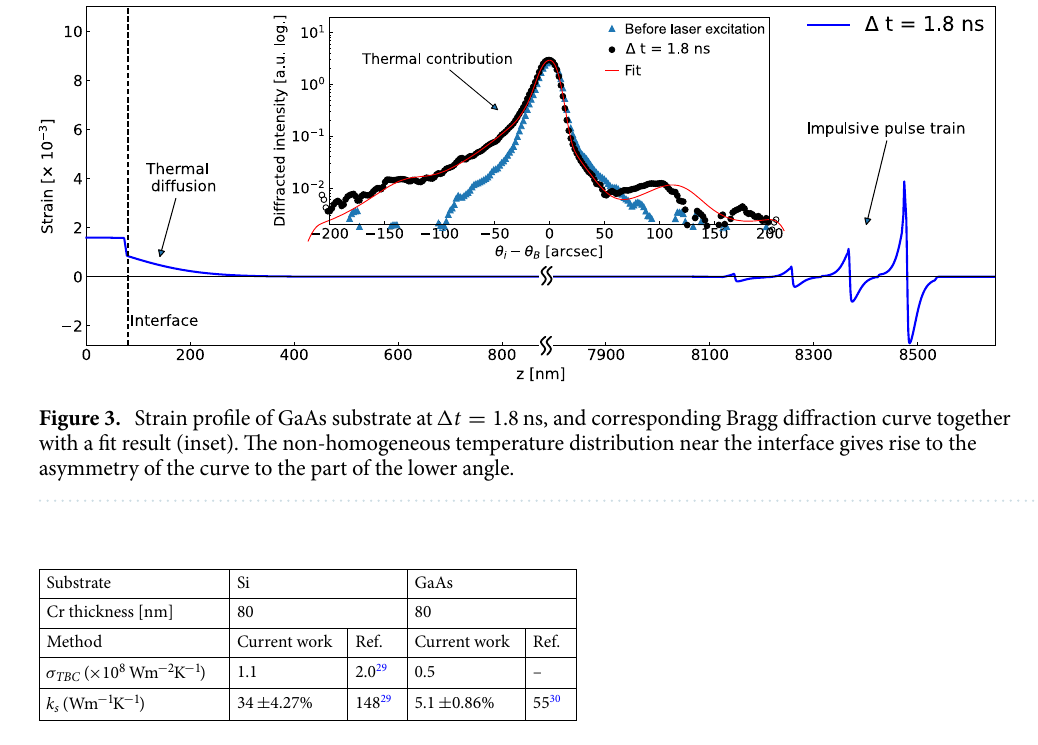
Table 1. Fitting parameters of thermal boundary conductivity and thermal conductivity of the samples.